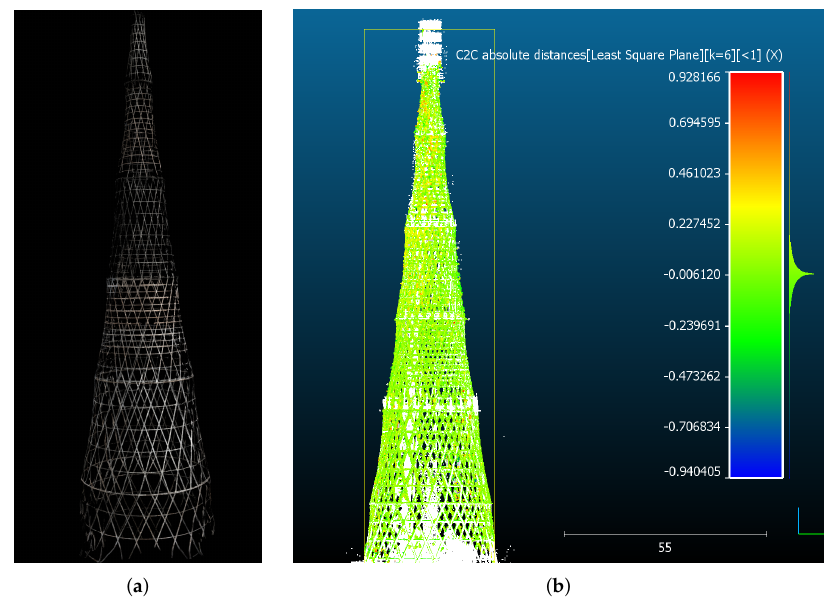
Figure 15. Textured full 3D model of the tower ( a ), and point-to-point alignment and comparison the two point clouds: image-based and manually processed laser scanning data ( b